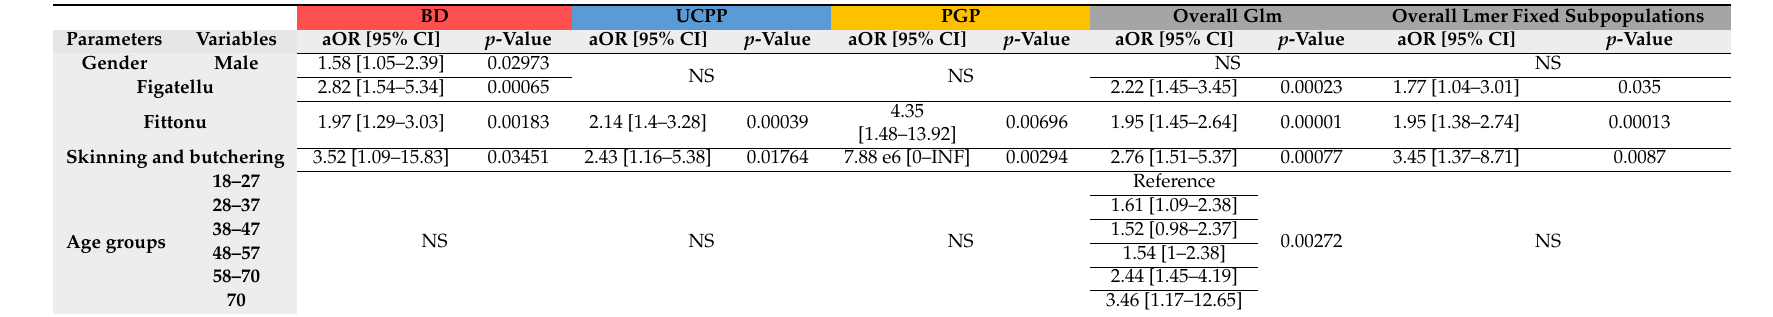
Table 2. Multivariate analysis in the three populations and